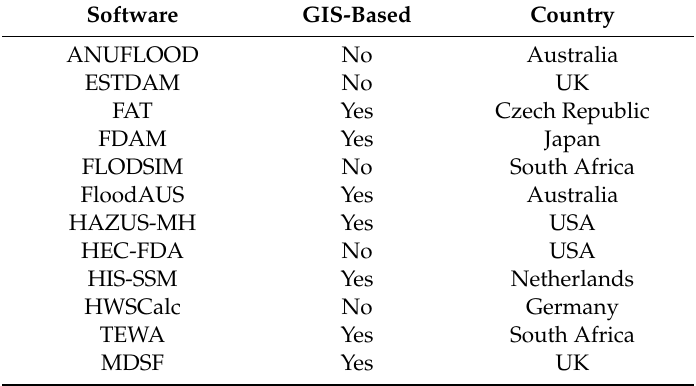
Table 3. Popular software tools, their compatibility to geographic information systems (GIS), and their country of